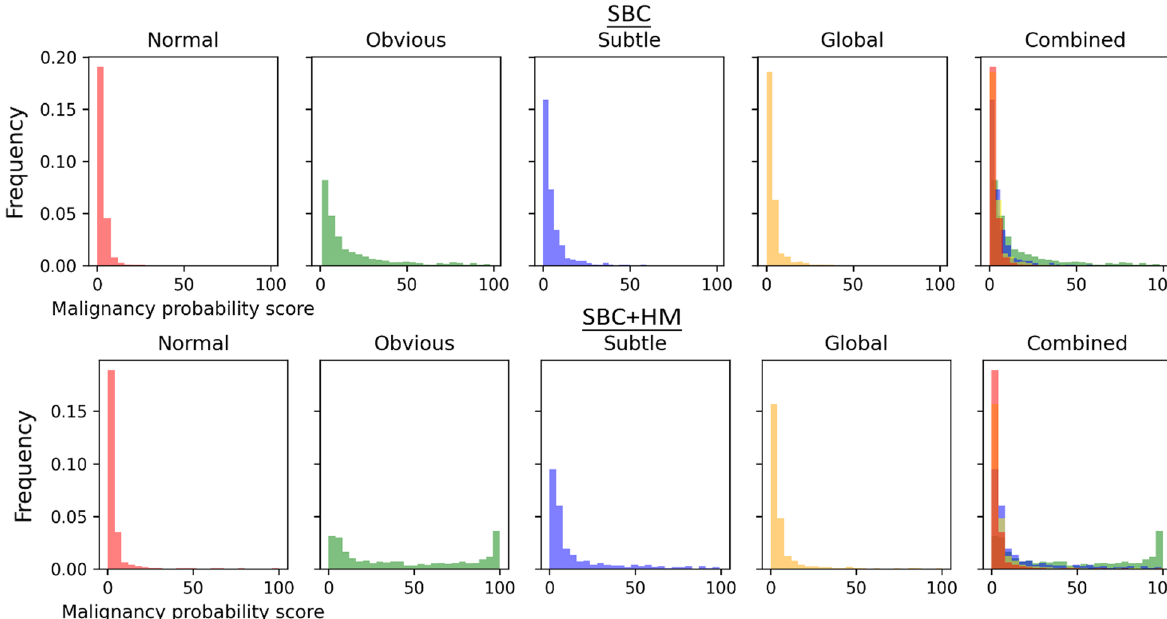
Fig. 6 Distribution of single breast classifier (SBC) and SBC mammograms split into 25 bins for each of the image type categories, with a combined plot showing the overlap between normal (red), obvious (green), subtle (blue), and global (yellow)